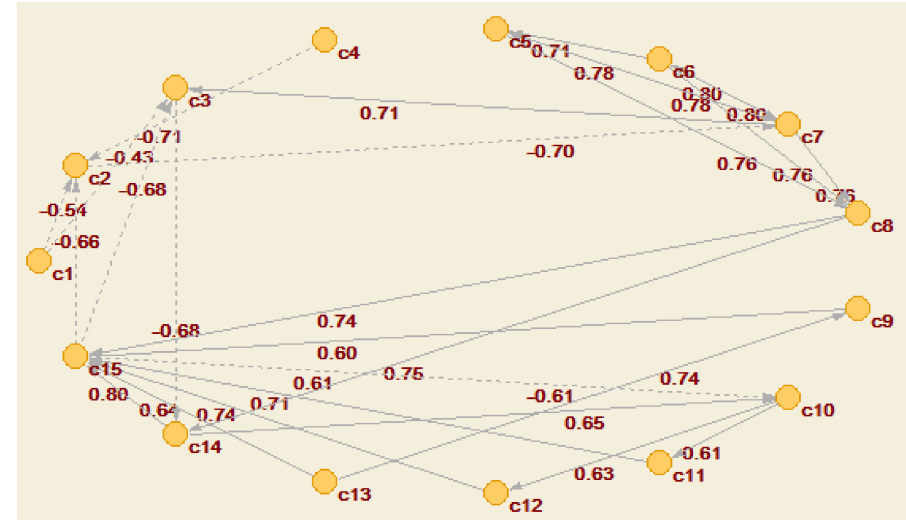
Figure 1. Causal Model of Sustainable Hospital Supply Chain